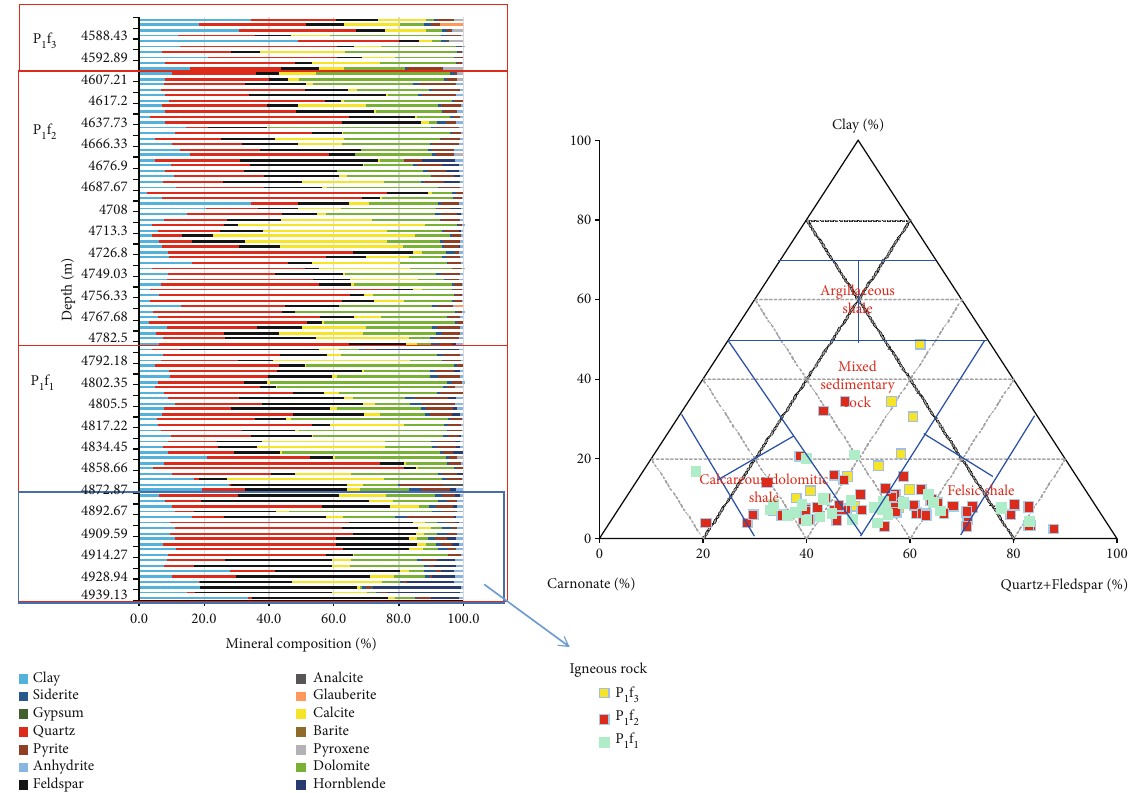
Figure 4: Mineral composition and lithofacies division of Fengcheng Formation